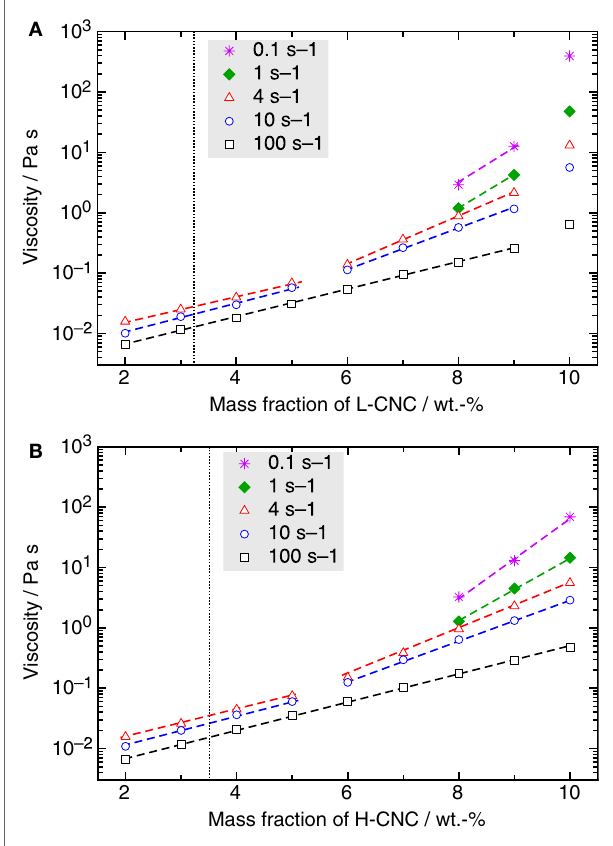
Mass fraction of H-CNC / wt.-% FigUre 9 | semi-logarithmic representation of the viscosity versus mass fraction w of (a) l-cnc and (B) h-cnc for different shear rates . The transition from isotropic to the biphasic region, as estimated from the phase separation experiments in Figure 3 , is indicated by a dotted vertical line. In general, there is a logarithmic increase of the viscosity with increasing mass fraction of CNC, with a slope in this lin–log diagram changing around 5 wt.-% for low shear rates. (Dashed lines are guides for the eyes to highlight this behavior.) However, in the case of L-CNC a sudden jump in the values occurs beyond w ≥ 10 wt.-%, indicating that the concentration threshold for kinetic arrest is between 9 and 10 wt.-%.